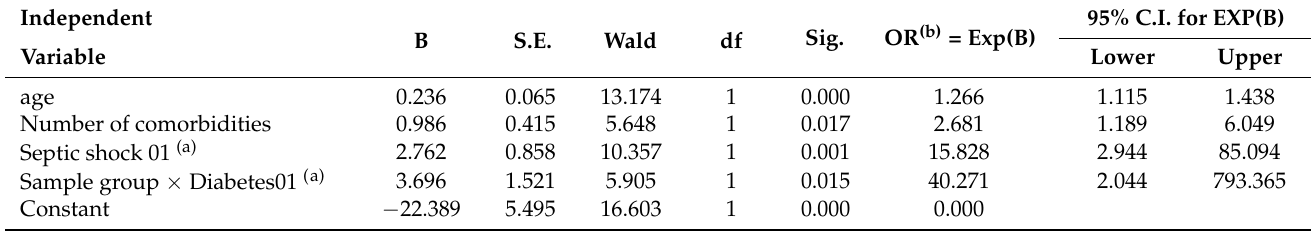
Table 5. Logistic regression model for dependent variable